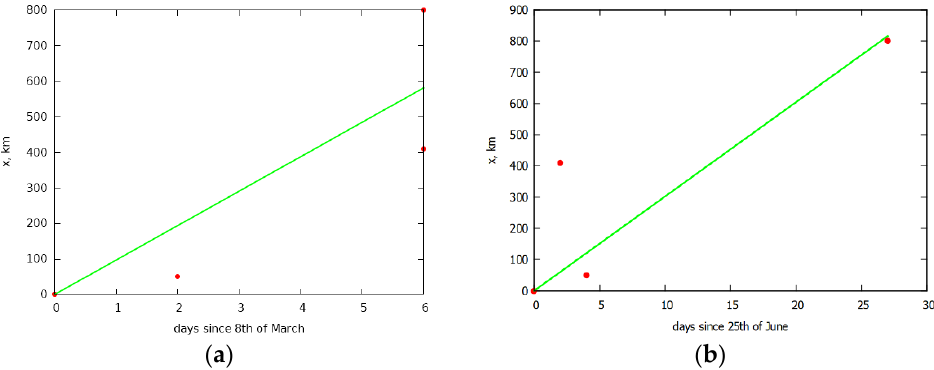
Figure 6. Graphs for determining ( a ) speed of spread of the epidemic and ( b ) speed of recovery in southern Chile.